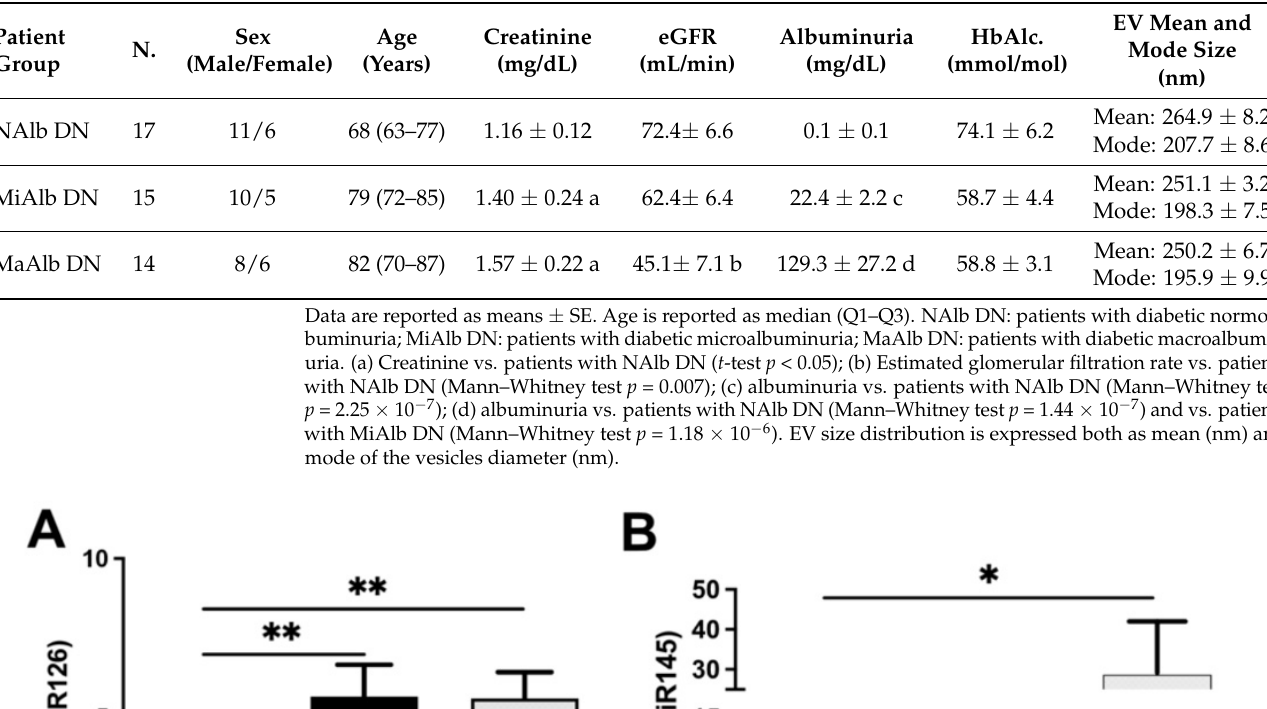
normalized to RNU6B (* p < 0.05 and ** p < 0.001).